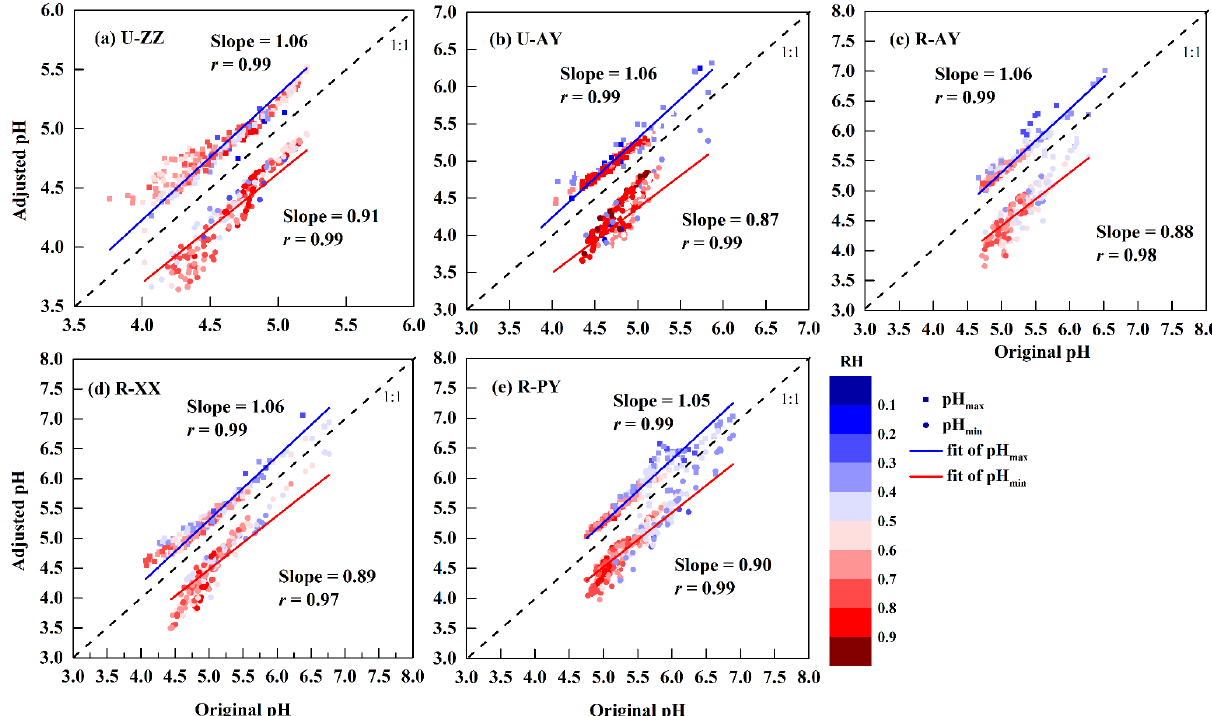
Figure 1. pH uncertainties of the five sites based on two extreme scenarios of measurement uncertainty. Cations and organic carbon con- centrations (OC) were adjusted up to within their maximum positive uncertainties; anions, relative humidity (RH), and temperature ( T ) were adjusted down within their maximum negative uncertainties, which represented the pH max case; for the pH min case, cations and OC concentrations were adjusted down, and anions, RH, and T were adjusted up. The color scale bar represents adjusted